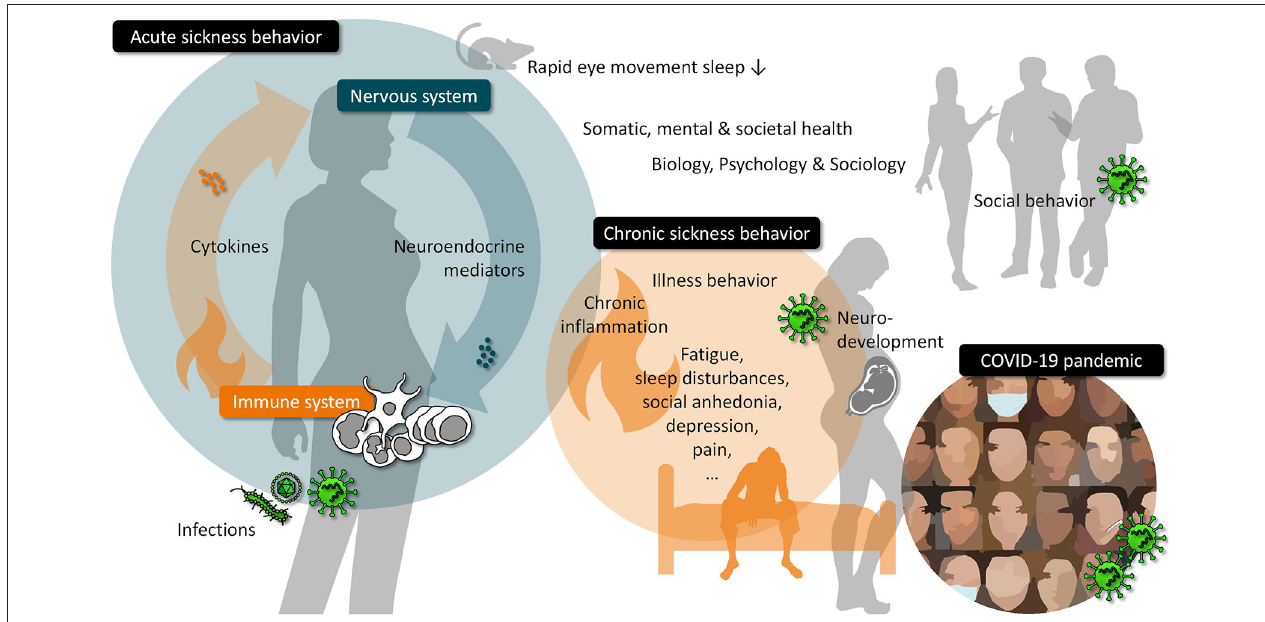
FIGURE 1 | Overview on topics related to the interplay between the immune system, sickness (behavior) and social as well as psychological